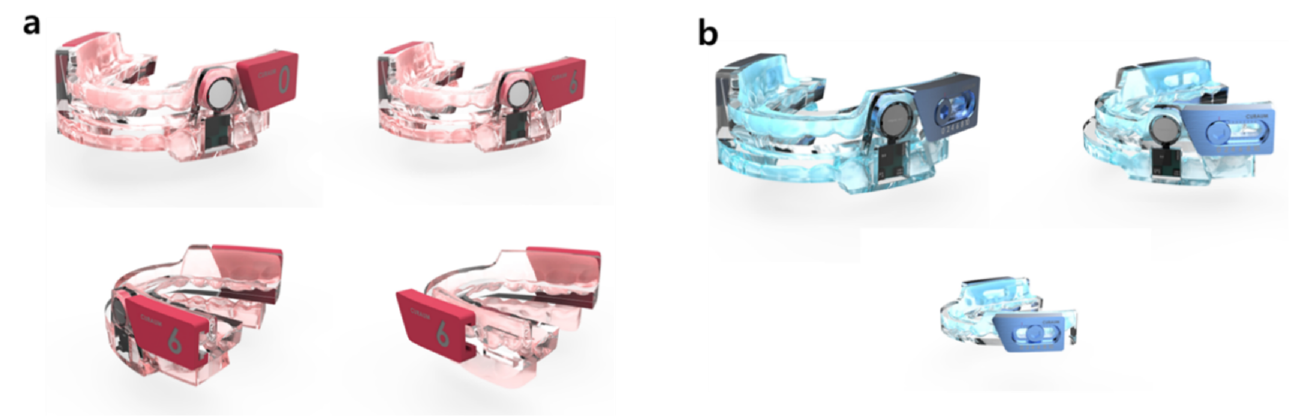
Figure 4. Cover-sliding type ( a ) and button-sliding type ( b ) 3D design concept model of s-Guard